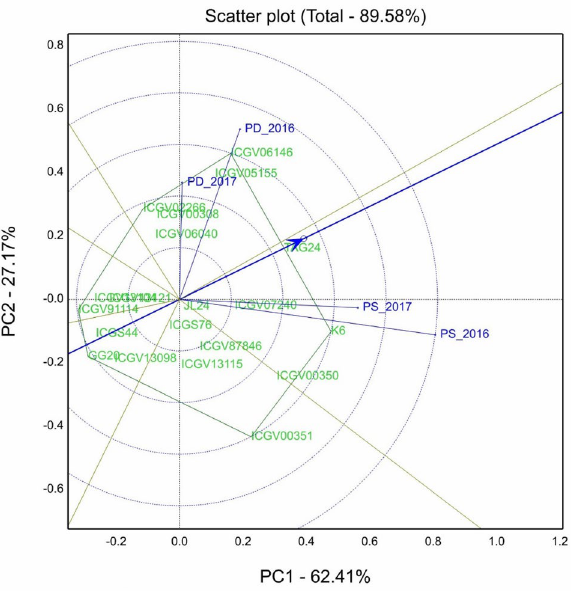
Figure 2. GGE biplot showing best genotypes for pod yield per plant under P-sufficient and P-deficient conditions under 2016 and 2017 pot experiment. PS_2016—P-sufficient condition under 2016; PS_2017-